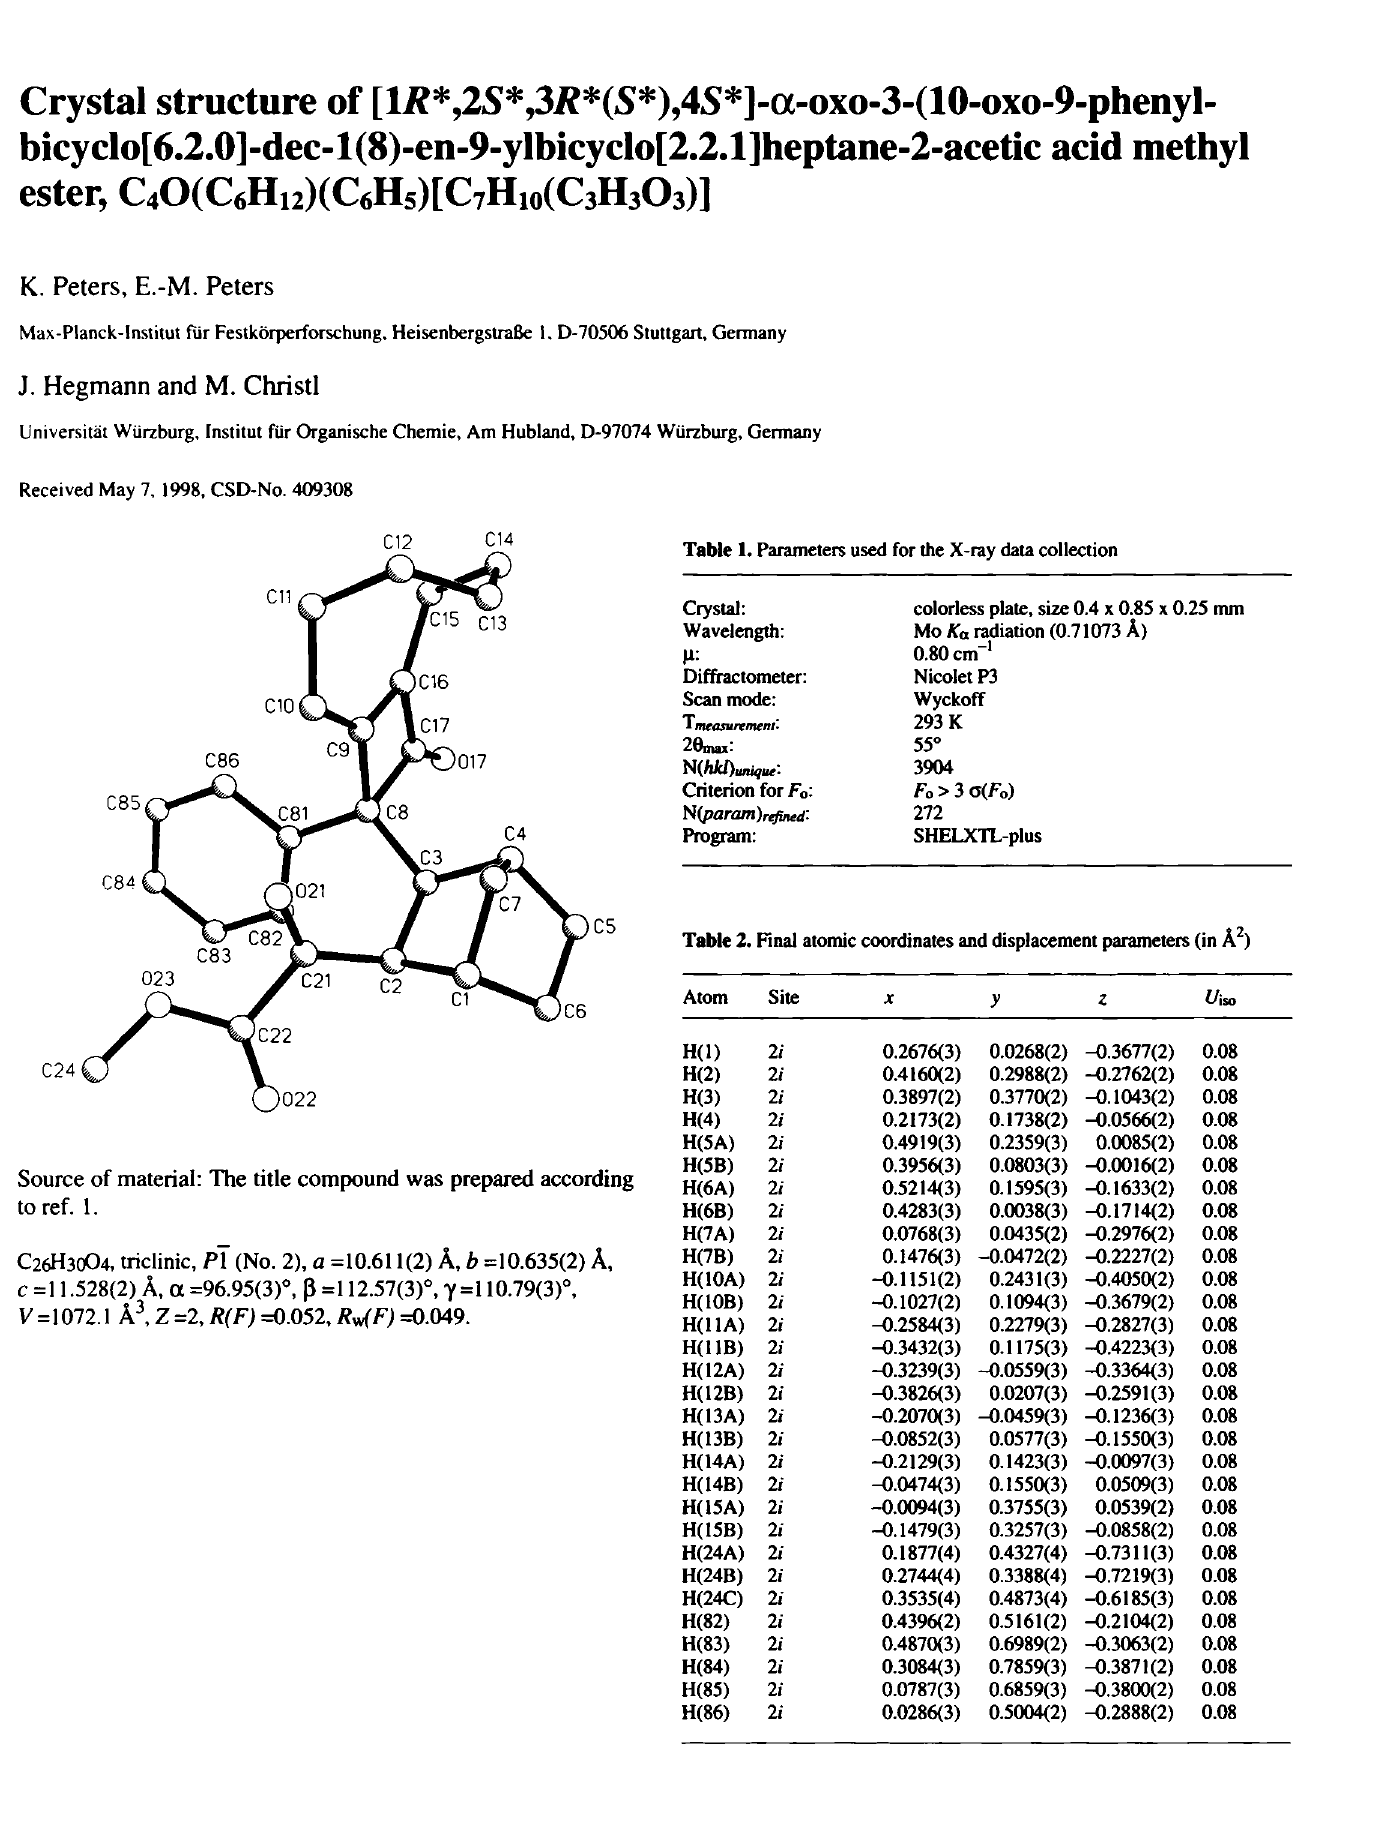
Table 2. Fmal atomic coordinates and displacement parameters (in